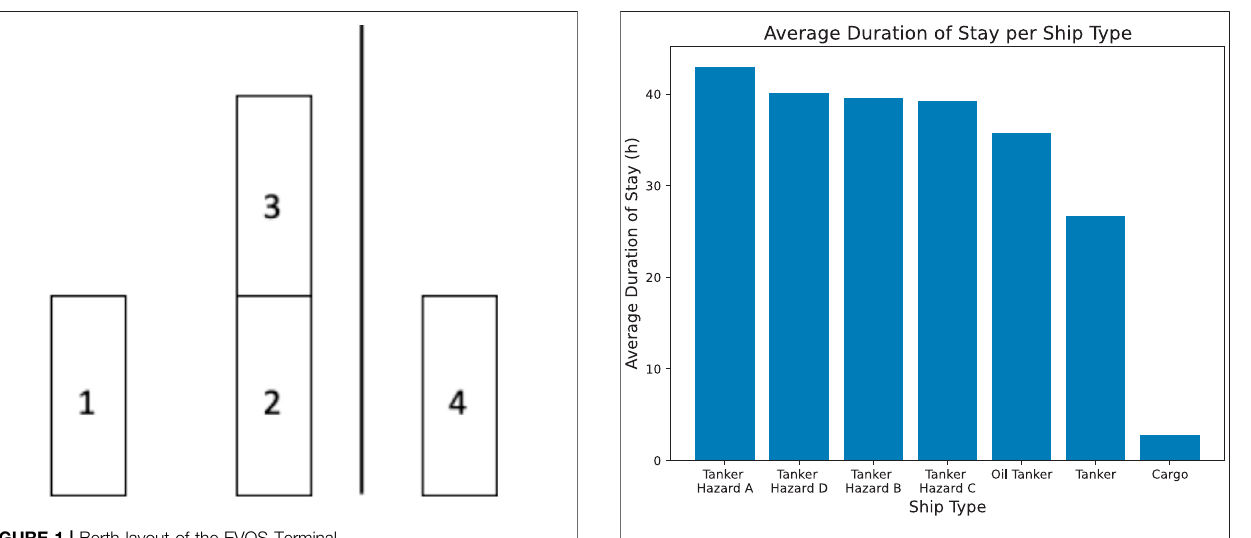
FIGURE 2 | Average duration of stay per ship